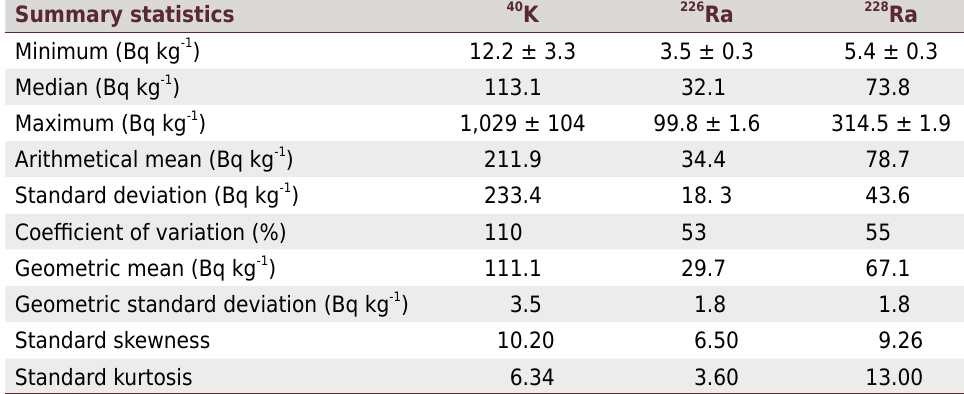
Table 3. Summary statistics for the radionuclides analyzed in pooled soil samples (n = 243) Summary statistics